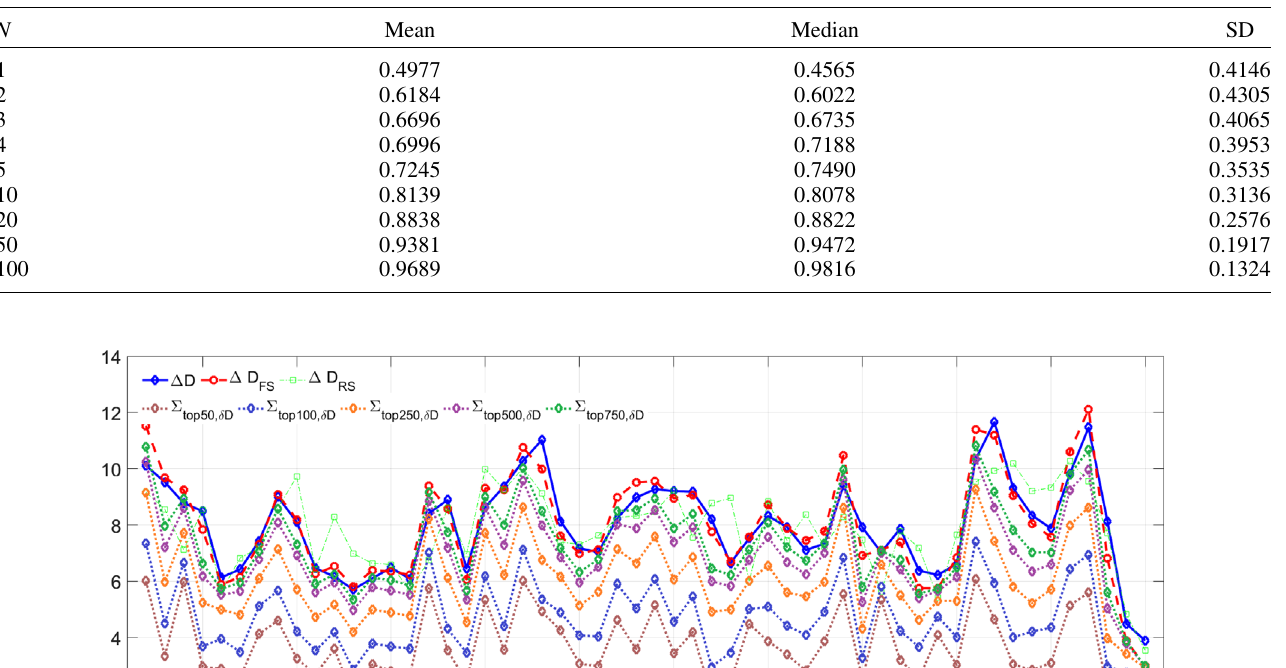
Table 1. Means, medians and standard deviations (SD) of the total ARDoR of the top N ARs divided by the total ARDoR of all ARs for cycles where the total ARDoR exceeds 15% of the absolute change in the dipole moment D D (230 cycles).